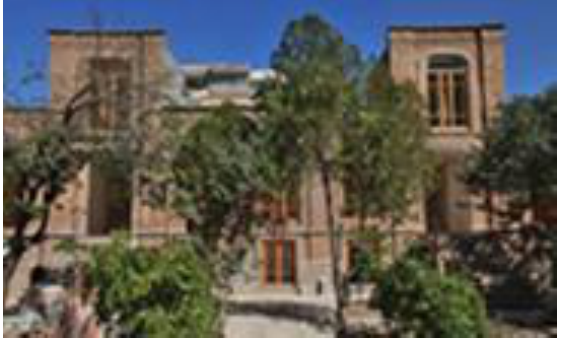
Figure 6 Courtyard house No.5 (Source: Iran Cultural Heritage, Handicrafts and Tourism